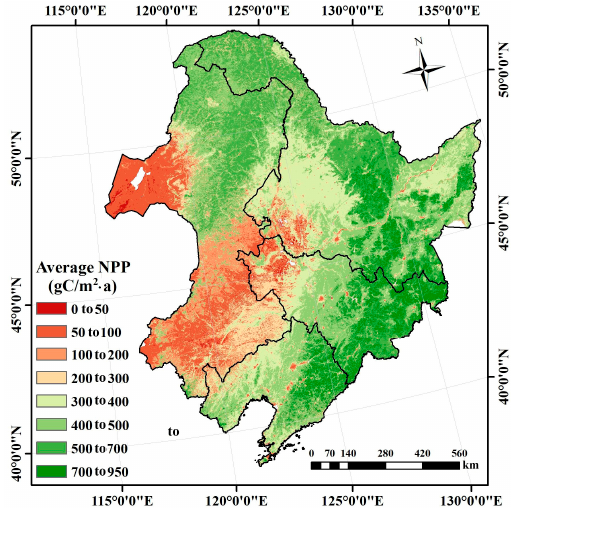
Figure 1. Validation of the simulated net primary productivity (NPP) from the boreal ecosystem productivity simulator (BEPS) model.